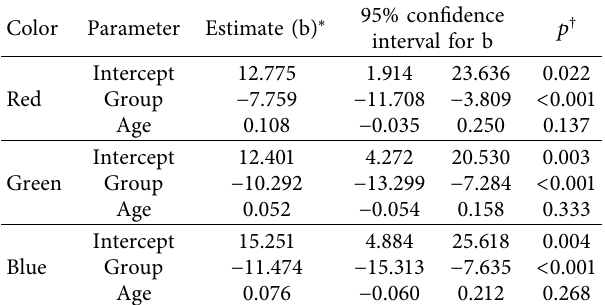
∗ b : mean differences in intensity thresholds (%) for target recognition between patients with AMD and controls. † p values < 0.05 indicate sta- tistically significant differences. Linear mixed-effects model included group of eyes and age as fixed effects, and a random intercept for participant ∗